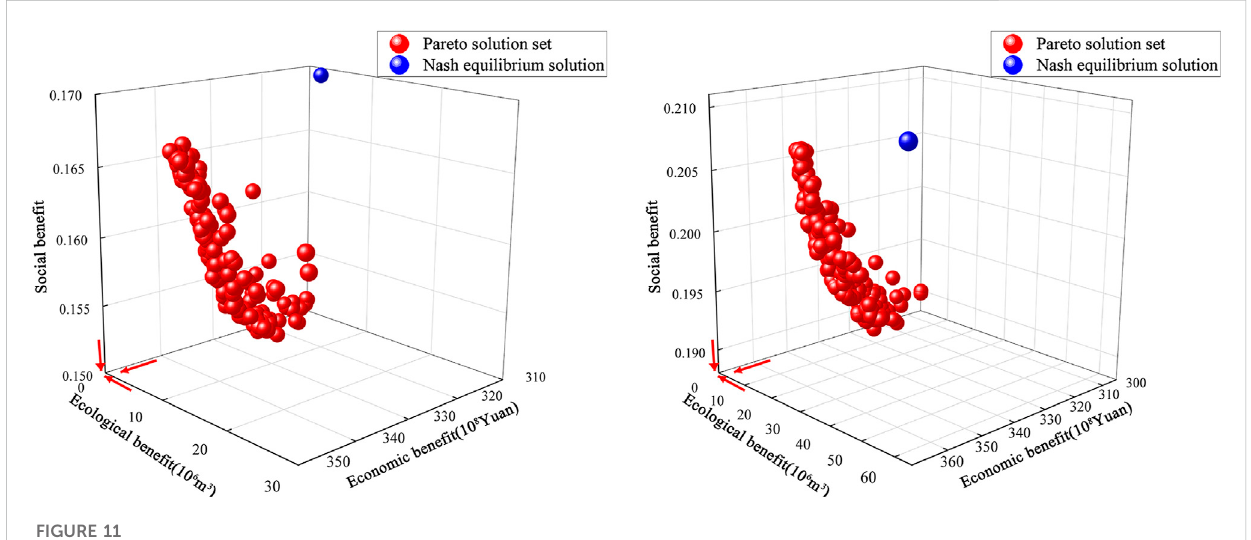
FIGURE 11 Spatial relationship between Pareto solution sets and Nash equilibrium